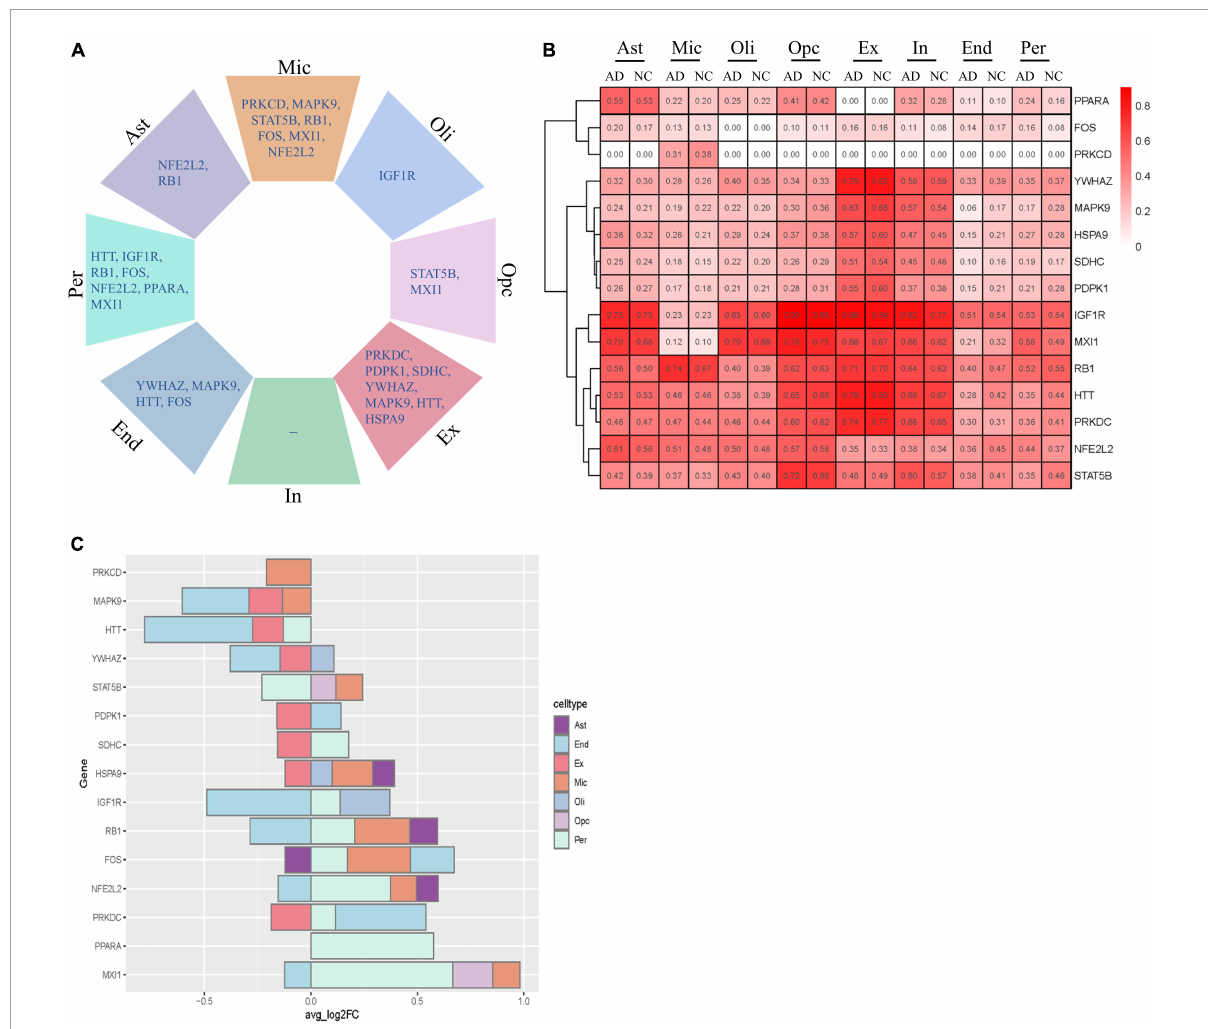
FIGURE7 Cell type-specific alterations of key AGs in AD. (A) Key DEAGs in different NVU cell types. (B) The expression levels of key AGs in each NVU cell type. (C) Differentially expressed key AGs in NVU cells between AD and NC. AD, Alzheimer’s disease; AGs, aging-related genes; Ast, astrocyte; DEAGs, differentially expressed aging-related genes; End, endothelial cell; Ex, excitatory neuron; FC, fold change; In, inhibitory neuron; Mic, microglia; NC, normal control; NVU, neurovascular unit; Oli, oligodendrocyte; Opc, oligodendrocyte progenitor cell; Per,